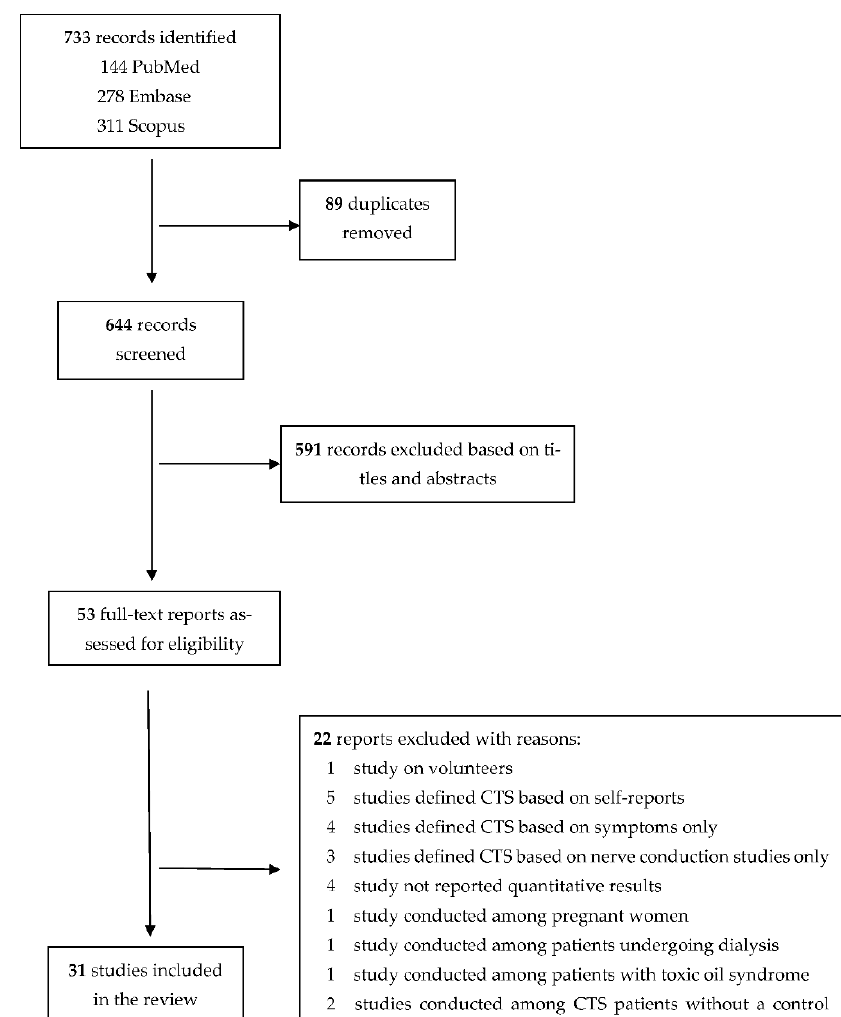
Figure 1. PRISMA flow diagram of study selection.